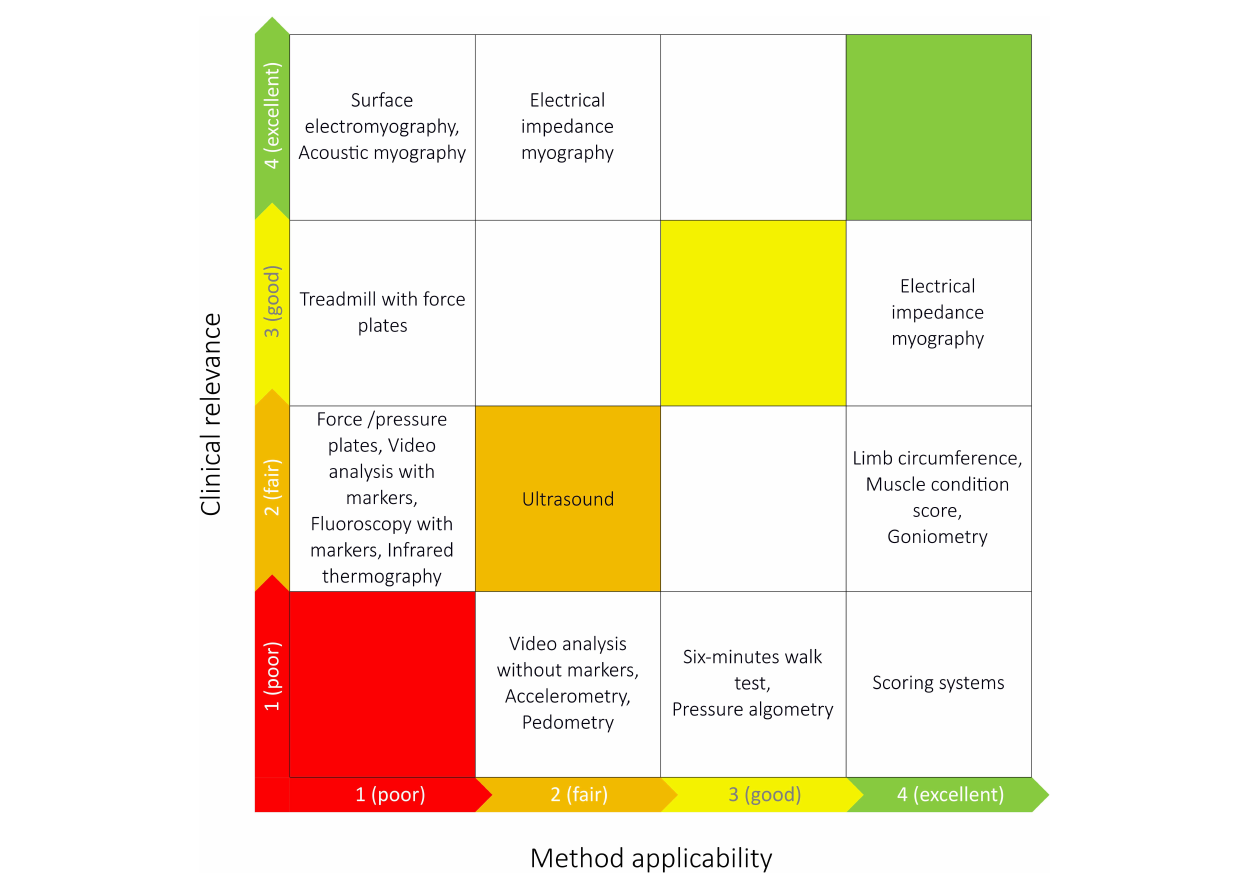
FIGURE4 The grading of the identified muscle function assessment methods made by experts in biomechanics (x-axis) and clinical experts (y-axis) in relation to dogs with cranial cruciate ligament disease. The most optimal techniques are placed closer to the upper right corner, and the least optimal closest to the lower left